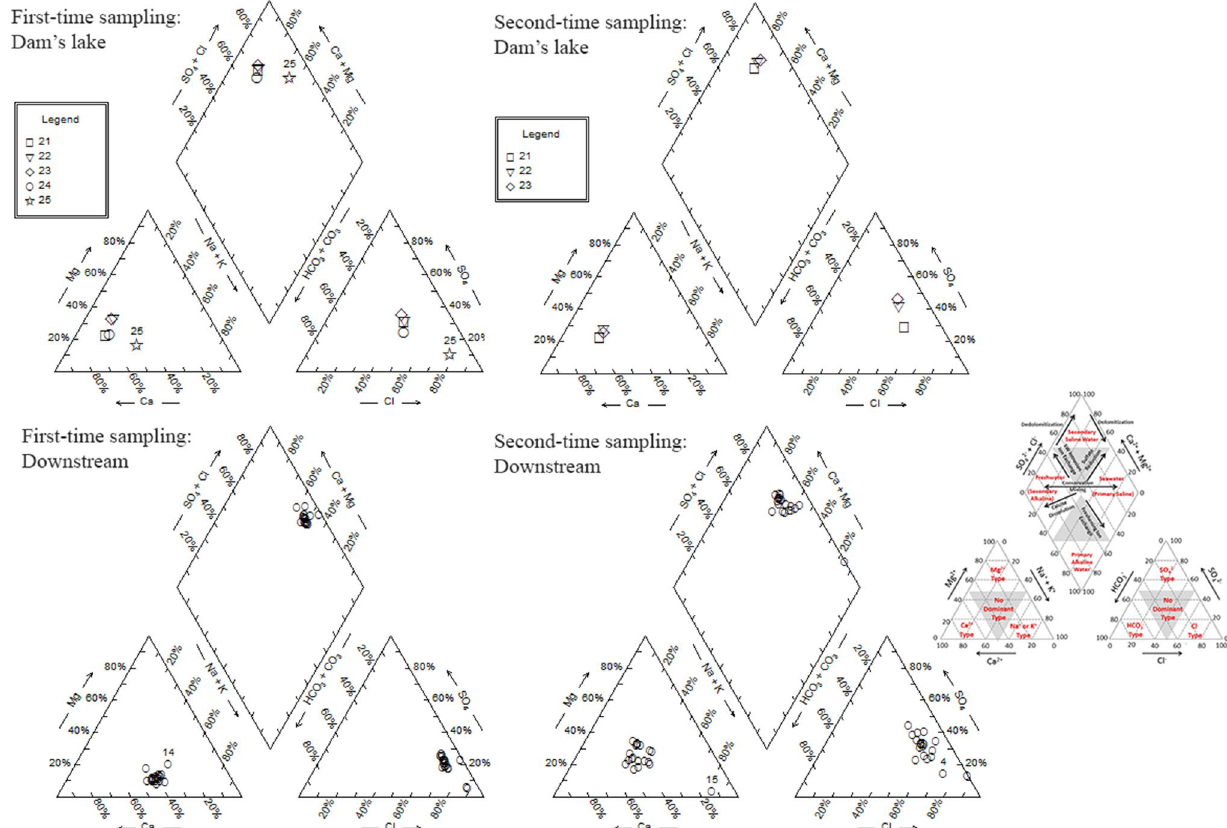
Fig. 2 Type of the water sample of the Karun River in the lake and downstream of the Gotvand-e-Olya